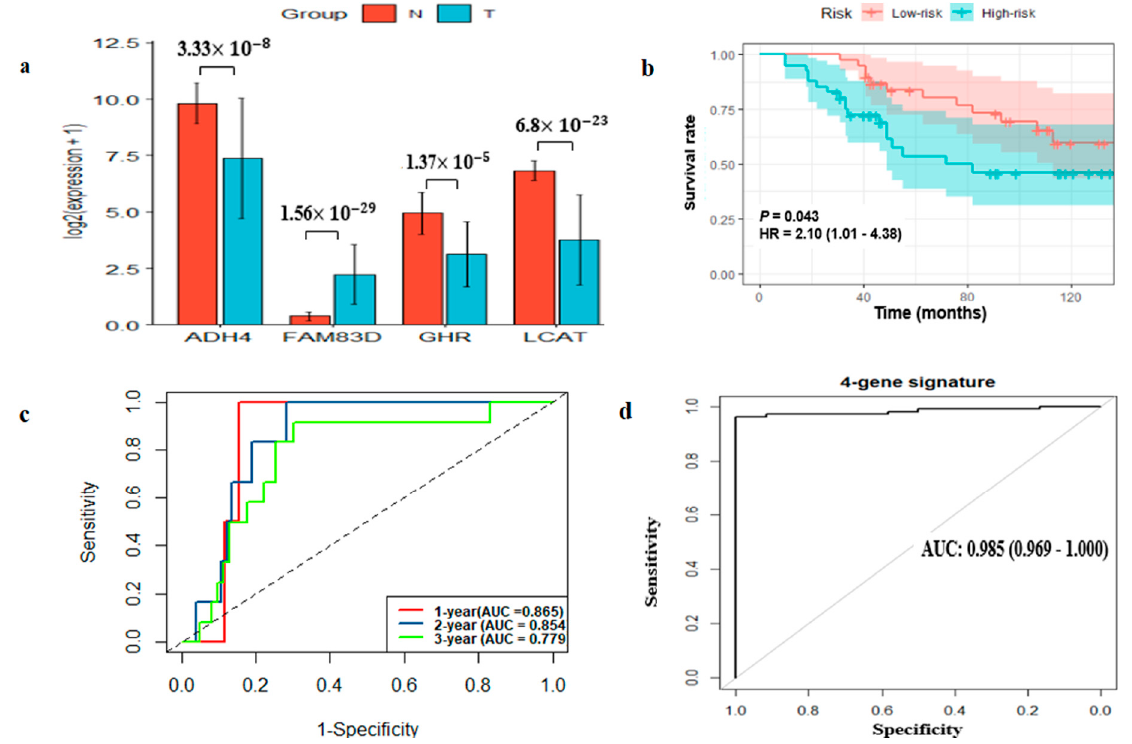
Figure 6. Comparison of expression level of the four-gene signature verified by our hospital samples. The relative expression level of ADH4 , LCAT , GHR and FAM83D between HCC and normal tissues ( a ). Kaplan–Meier (KM) survival analysis for high-risk and low-risk subgroups classified by RS model ( b ). Verification of four-gene signature by time-dependent ROC analysis classified by RS model ( c ). The four-gene signature diagnostic performance in classifying HCC and normal tissue separated by RS model ( d ). RS, Risk score.